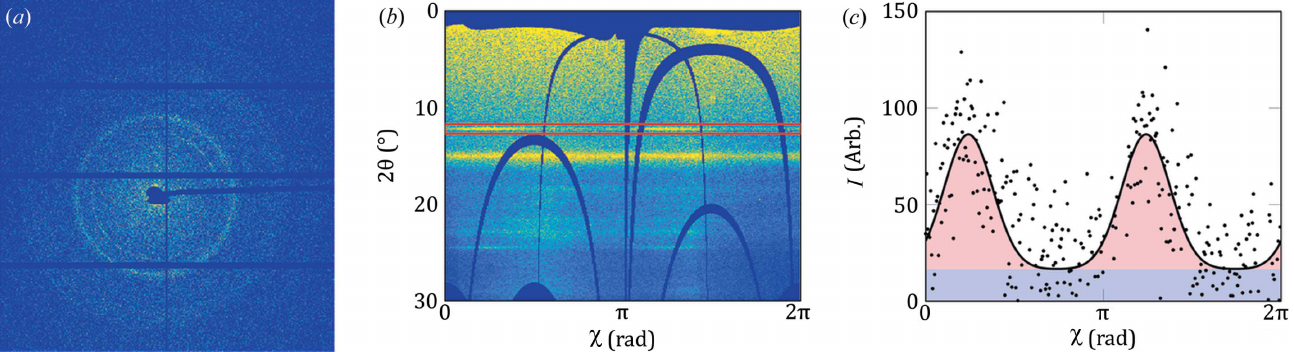
Figure 3 Example of test data. ( a ) Raw detector frame. ( b ) Azimuthally resolved detector frame after MatFRAIA integration, with the HAP (002) peak